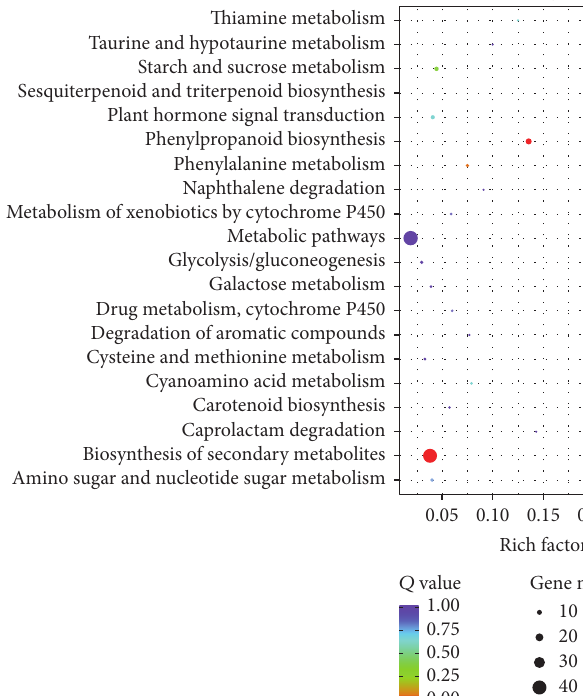
phenylpropanoid derivatives, including RA, flavonoids, and lignin